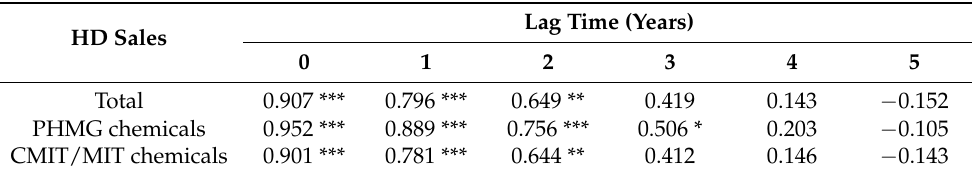
Table 3. Spearman’s rank correlation coefficient between NHIS-recorded HDLI cases (S27.3) and